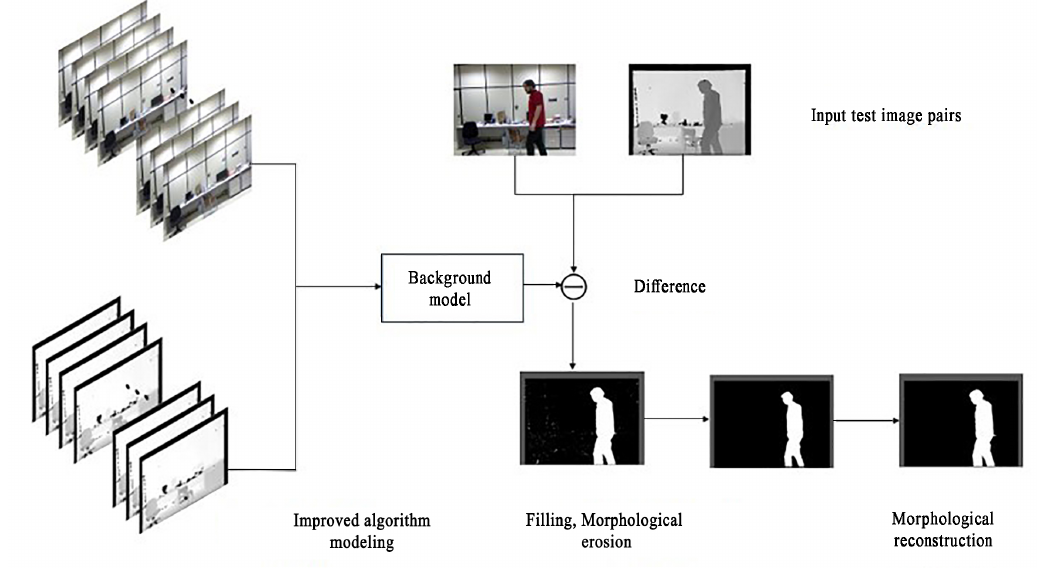
Figure 3. The improved RGB-D based codebook moving object detection algorithm framework in this